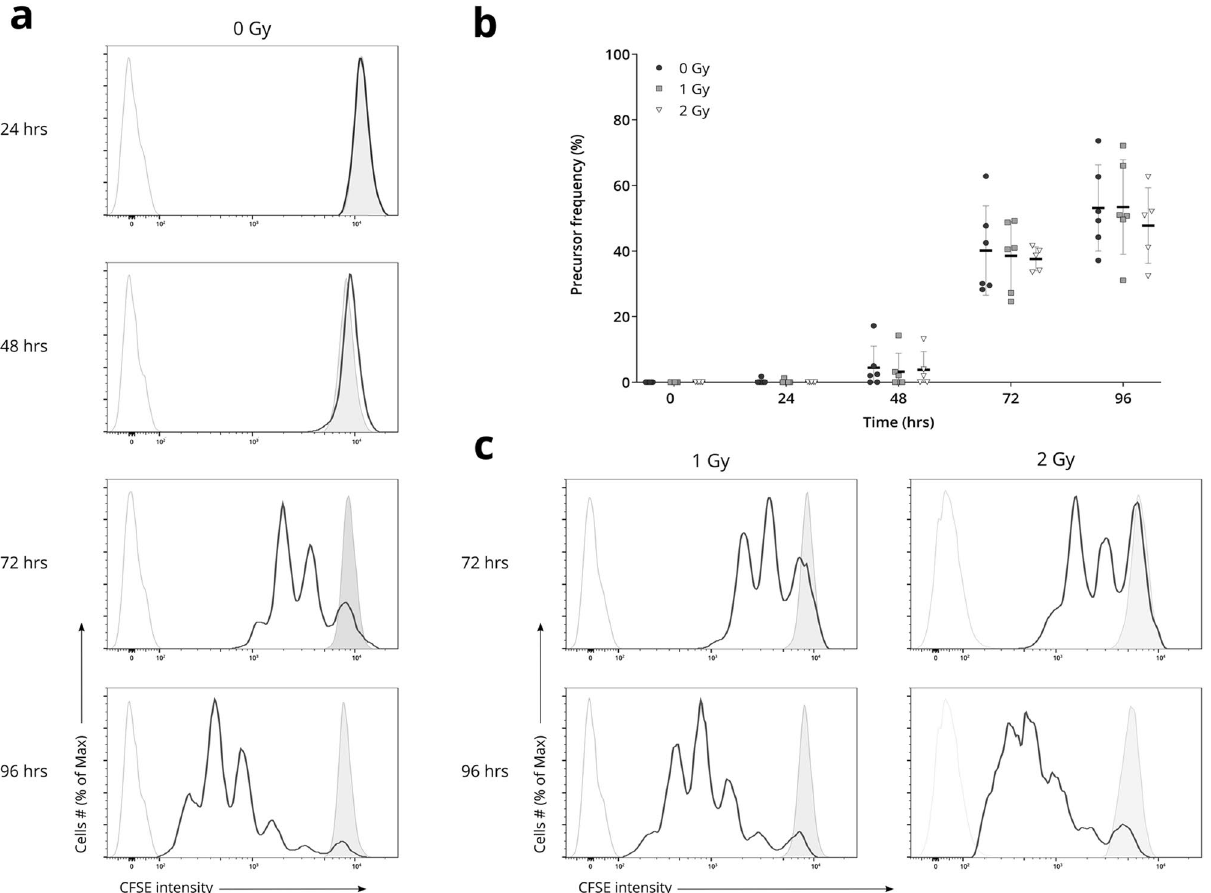
Figure 2. Proliferation analysis of CFSE-labeled T lymphocytes after PHA stimulus. T lymphocytes were exposed to 0, 1, and 2 Gy of 220 kV X-rays and cell proliferation was examined at 0, 24, 48, 72, and 96 h. ( a ) Representative example of CFSE fluorescence profiles of live non-irradiated T lymphocytes. The open black histograms show stimulated CFSE-labeled cells. The solid grey histograms show unstimulated CFSE-labeled control samples. The open grey histograms show the autofluorescence of stimulated control samples, not labeled with CFSE. ( b ) The precursor frequency (PF) of CFSE-labeled cells for each irradiation dose, at various time points. Individual datapoints of 6 independent experiments are shown, with the mean ± standard deviation. No statistically significant differences were found ( p > 0.05) between irradiation doses. ( c ) Representative example of CFSE fluorescence profiles of live irradiated T lymphocytes visualized as described for